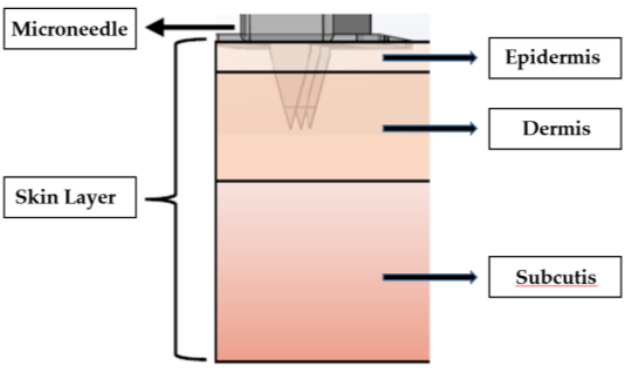
Figure 4. The microneedles penetrate the skin; the length of the microneedles is 1 mm, which is adequate to penetrate the skin and reach the dermal tissue.